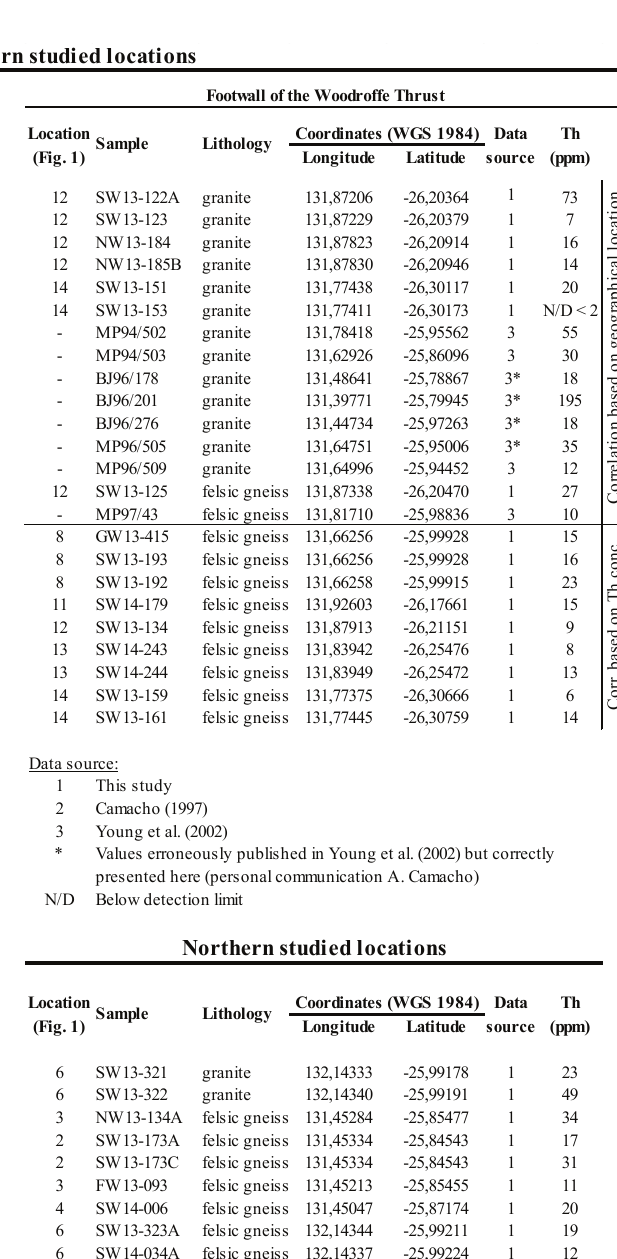
Table 2. Thorium concentrations in felsic gneisses and granitoids from the hanging wall and footwall of the Woodroffe Thrust, central Musgrave